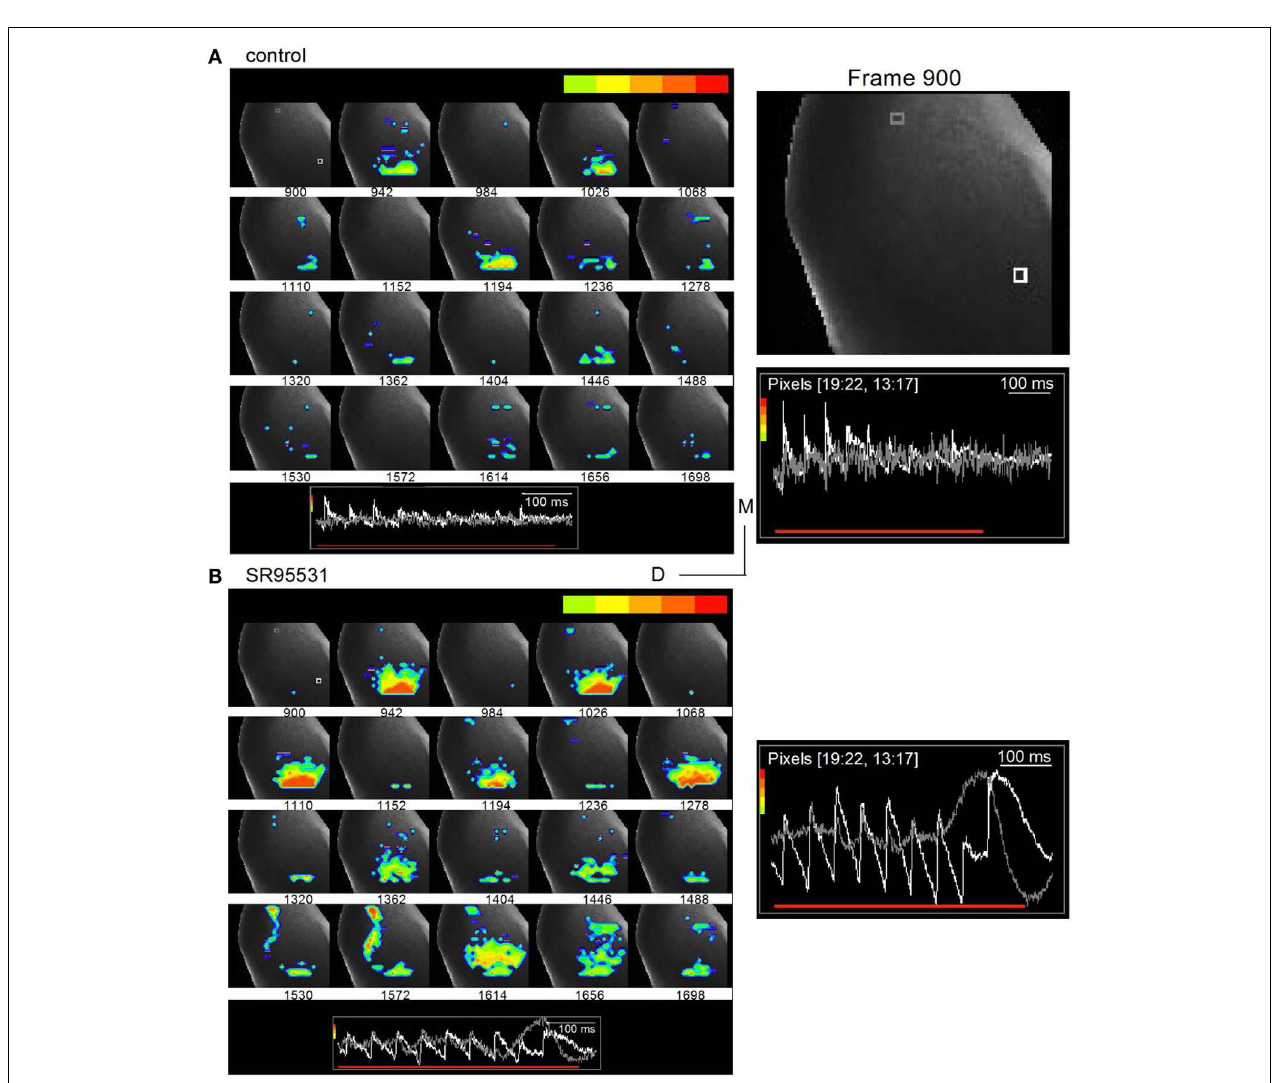
White pixel, ICC; gray pixel, commissure. Frames are 25ms apart. (B) 20 µ m SR95531. Insets, traces correspond to the white and gray pixels highlighted in the first frame (frame 900) in the top panel.The gray pixel is in the commissural region. Right panel, Expanded image of inset traces of responses in the white and gray pixels. Pixelated areas in frame 900 [ (A) , right panel] also applies to (B) . Frame intervals are the same as in (A) . Directional scale bar applies to both